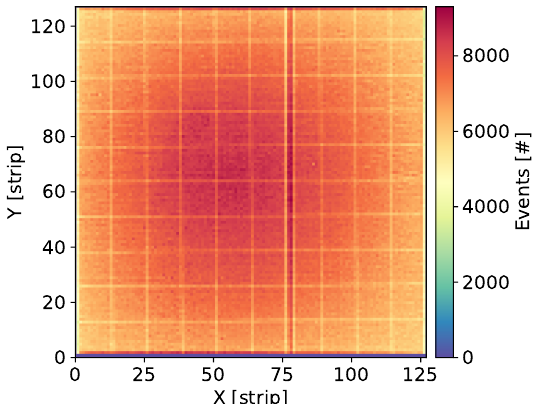
Figure 11. GEM detector C 2 . Map of cumulative counts of reconstructed events for detector bias voltage of 3840V.